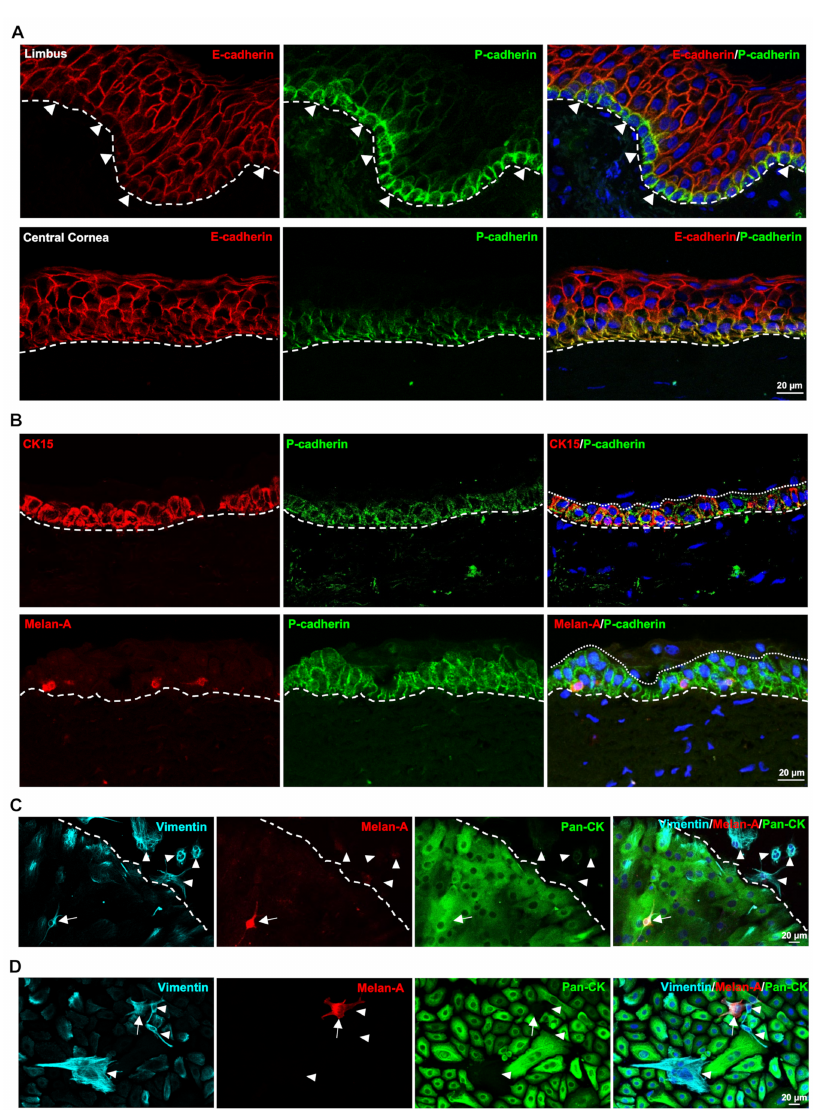
Figure 2. Characterization of the corneal limbus and unsorted cultures: ( A ) Immunohistochemical staining of fresh corneoscleral tissues showing non-colocalization of the P-cad + cells (green) with E-cadherin (no expression or rather weak expression; red, arrowheads), whereas colocalization of P-cad + cells with E-cadherin in basal corneal epithelium (dashed line represents the basement membrane (BM)). Nuclear counterstaining with 4 (cid:48) ,6-diamidino-2-phenylindole (DAPI, blue). ( B ) Dou- ble immunostaining of organ-cultured corneoscleral tissues showing the co-localization of P-cad + cells with CK15 and Melan-A (red, dashed line represents BM; dotted line separates P-cad + and P-cad − cells). Nuclear counterstaining with 4 (cid:48) ,6-diamidino-2-phenylindole (DAPI, blue). ( C , D ) Triple immunostaining analysis of cultured limbal clusters ( C , dashed line represents the edge of the ep- ithelial colony) and cultured single cells ( D ) showing the presence of limbal epithelial cells (pan-CK + (green)vimentin + (cyan)), melanocytes (melan-A + (red)vimetin + (cyan); arrow) and stromal cells (vimentin + (cyan); arrowheads). Nuclear counterstaining with DAPI (blue). Immunostaining on organ-cultured corneoscleral tissue was also performed to see the effect of culture conditions on P-cad expression. Similar to fresh limbal tissues, immuno- histochemical staining showed the colocalization of P-cad + cells with CK15 and Melan-A (dashed line represents BM, Figure 2B); however, the quality of organ-cultured limbal tissue in terms of epithelial layers was reduced (especially superficial layers) as